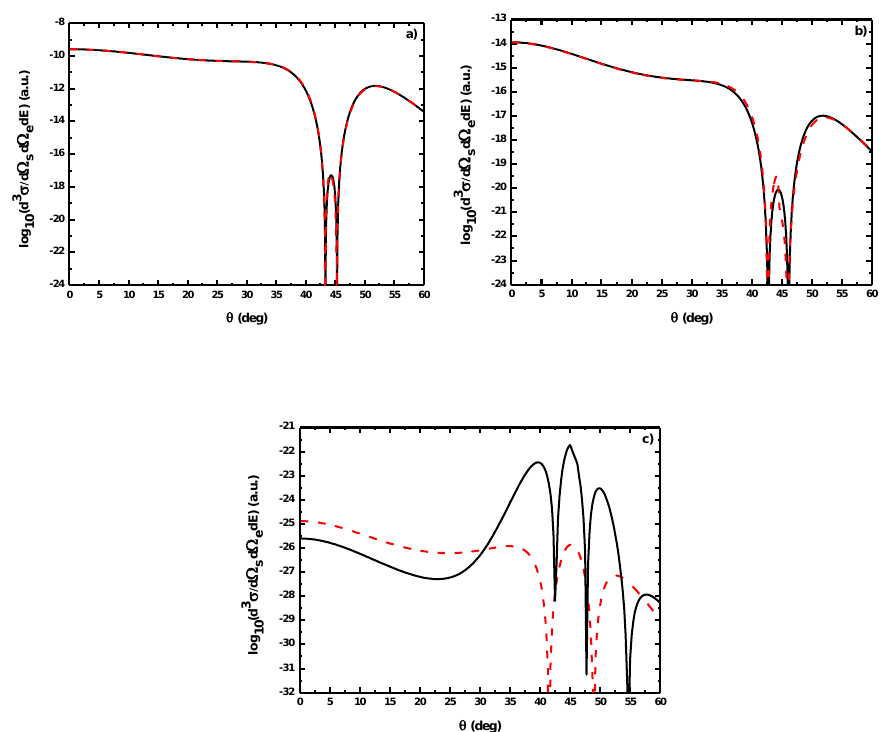
Figure 22. (Color online) Triple differential cross sections corresponding to the laser-assisted electron-impact ionization of atomic hydrogen in the ground state for the case of a coplanar symmetric geometry as a function of scattering angle θ = θ s = θ e for the absorption of two photons ( (cid:96) = 2). = 500 eV, and the electric field strength is E = 10 7 V/cm. The laser The incident electron energy is E k 0 i polarization vector is taken to be parallel to the transfer momentum ∆ . Solid lines: First Born approximation results. Dashed line: results obtained by neglecting the dressing of the target by the laser field. ( a ) The laser photon energy is ω = 1.17 eV; ( b ) ω = 2.34 eV; and ( c ) ω = 6.42